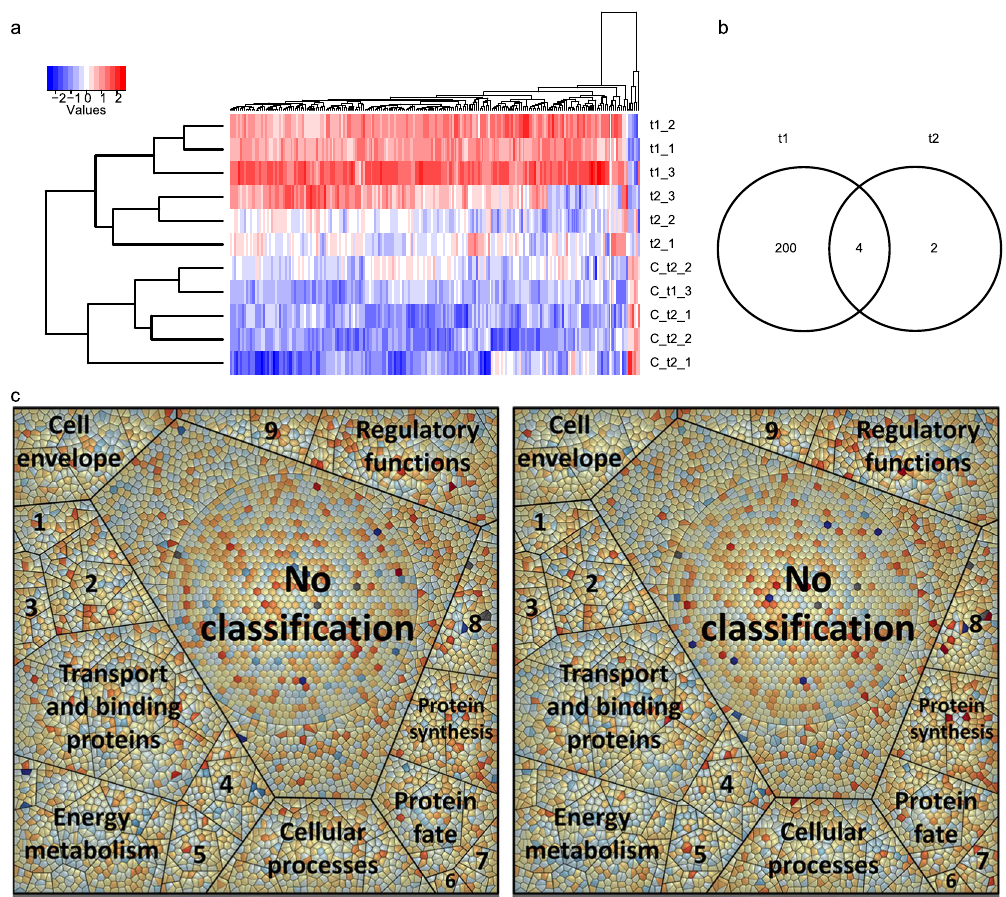
Figure 2. Changes in transcriptome of S. plymuthica PRI-2C in response to fungal VOCs. Heatmap of 206 DEGs with at least + / − 1.5-fold changes and a p-value less than 0.001 as a cut-off ( a ). Hierarchical clustering was performed using the Pearson Correlation metric. Venn diagram of uniquely and commonly expressed DEGs at t1 and t2 ( b ). Voronoi treemaps visualizing changes in the transcriptome of S. plymuthica PRI-2C exposed to fungal VOCs at t1 (C left) and at t2 (C right) ( c ). Functional classification of genes was carried out by Prophane 2.0 and is based on TIGRFAMS. Red color indicates higher expression of the respective gene and blue color indicates lower expression as compared to the control. Each cell represents a single gene; functional classes are separated by thicker black lines. Numbers indicate the following classes: 1 - Fatty acid and phospholipid metabolism, 2 - Biosynthesis of cofactors, prosthetic groups, and carriers, 3 - Purines, pyrimidines, nucleosides, and nucleotides, 4 - Amino acid biosynthesis, 5 - Central intermediary metabolism, 6 - Mobile and extrachromosomal element functions, 7 - Transcription, 8 - DNA metabolism, 9 - Signal